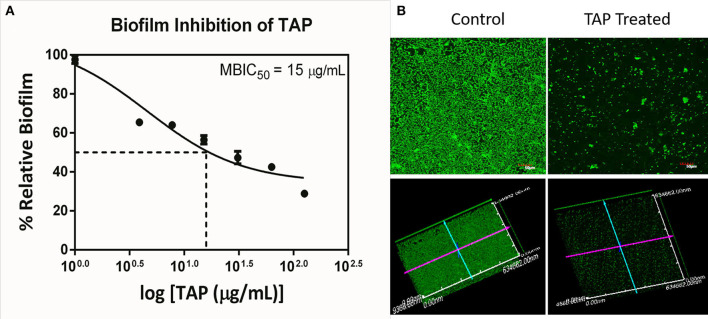
Biofilm Inhibition of TAP. (A) The monotonic dose-response curve of biofilm inhibitory action of TAP. The maximum biofilm inhibition was observed at 128 μg/mL. (B) The confocal micrographs of the biofilm inhibition at 128 μg/mL. Z-axis length is 10 μm.